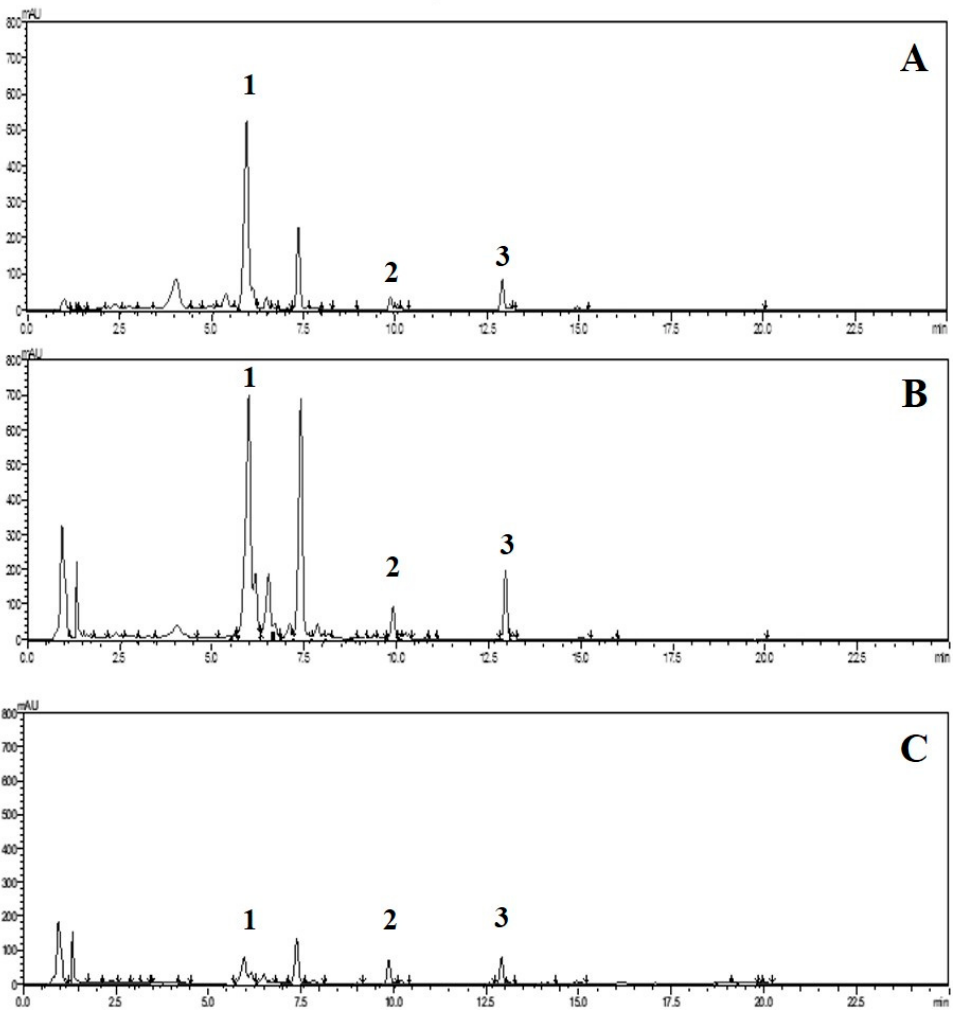
Figure 1. High-performance liquid chromatographic (HPLC) chromatograms of Oroxylum indicum extracts; A = seed extract (RAW), B = tissue-cultured plant shoot week 3 extract (TW3S), C = tissue-cultured plant root week 3 extract (TW3R). HPLC peaks; 1 = baicalin, 2 = baicalein, 3 = chrysin. Table 1. Flavonoid contents in O. indicum extracts determined by high-performance liquid chromatographic (HPLC).